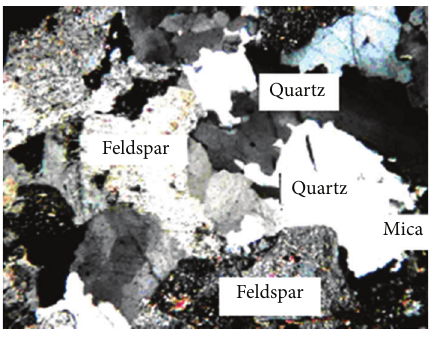
Figure 2: Micrographs of sands. Figure 3: Micrographs of crushed stone.